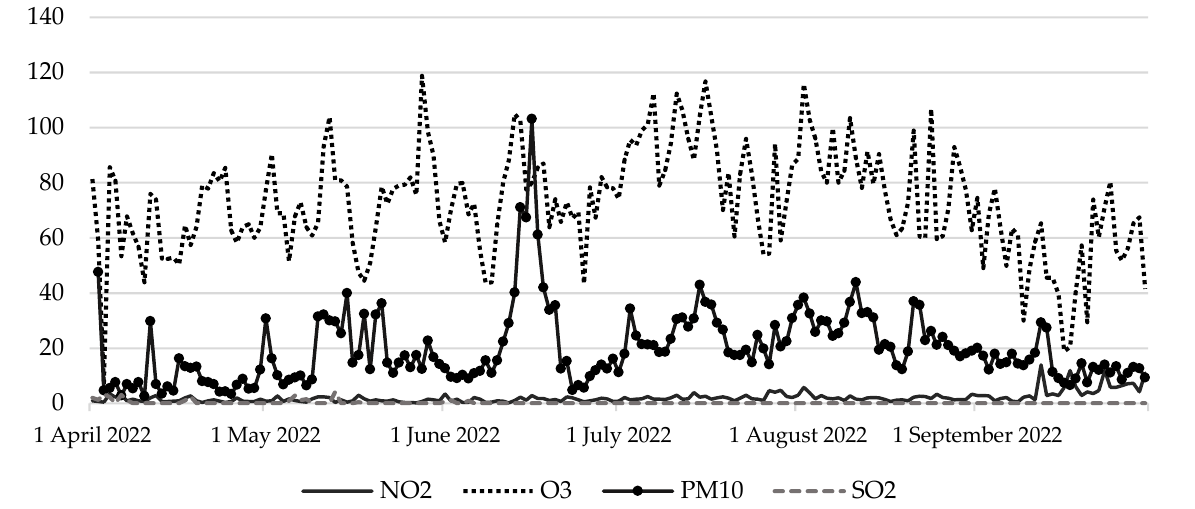
Figure 6. Variation in air quality in the city of Cáceres.